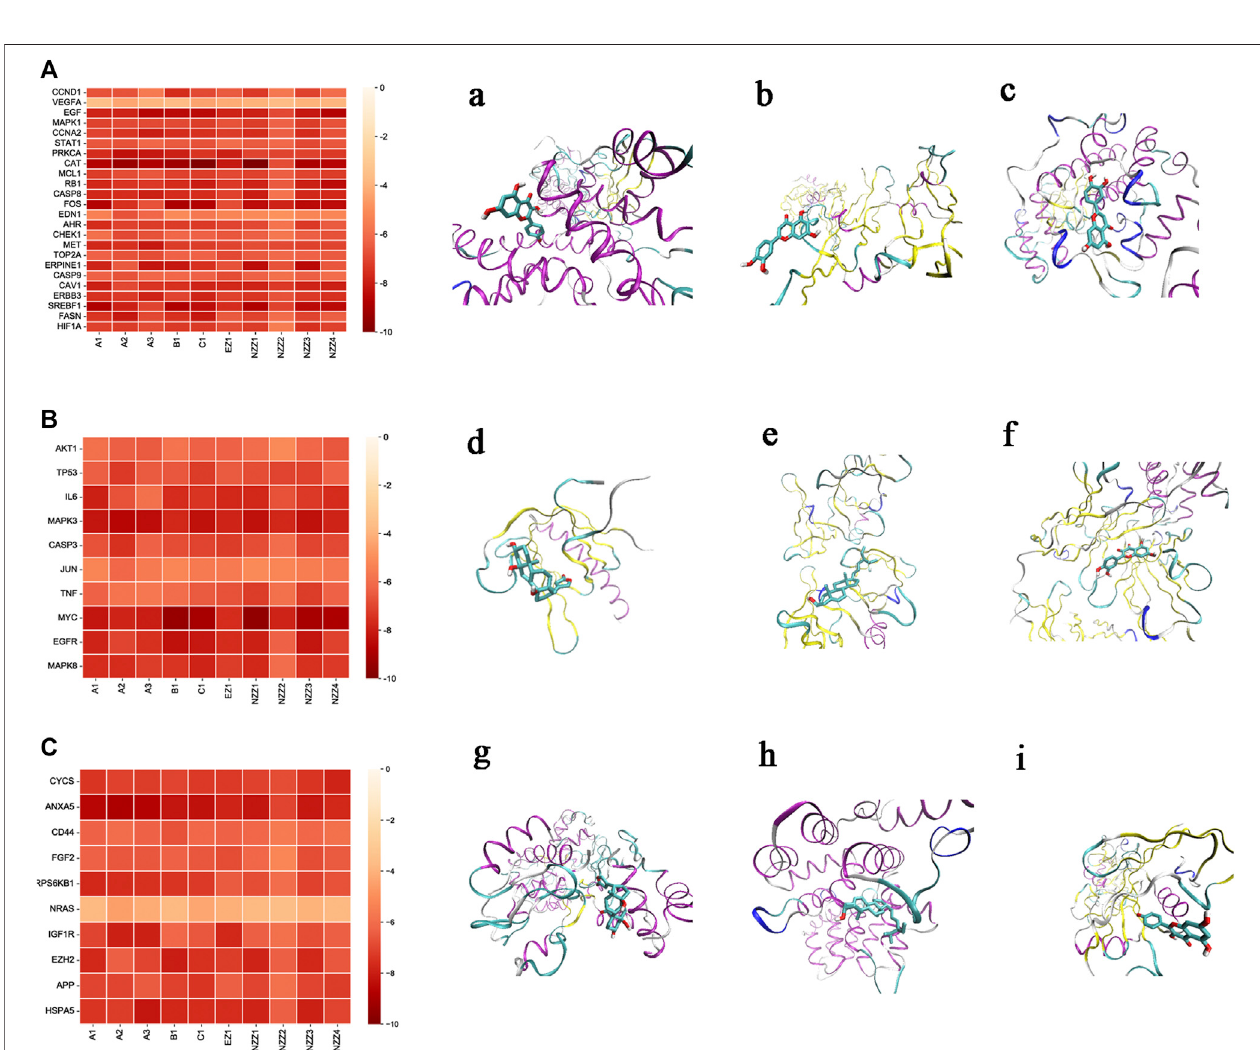
FIGURE7| Moleculardockingresults.Notes: (A) :Dockingresultsdiagramofcommontargetsandsmallmolecules. (a) :ThecorrespondingproteinofCCND1was visualized by docking with small molecule B1 with a docking score of − 7.6 kcal mol − 1 . (b) : VEGFA corresponds to the protein visualized by docking with small molecule C1 with a docking score of − 4.4 kcal mol − 1 . (c) : MAPK1 corresponds to the protein visualized by docking with the small molecule C1 with a docking score of − 7.2 kcal mol − 1 . (B) : Diagram of System Pharmacology model targets and small molecule docking results. (d) : The corresponding protein of AKT1 was visualized by docking with the small molecule NZZ4, with a docking score of − 6.6 kcal mol − 1 . (e) : TP53 corresponding protein was visualized by docking with small molecule A2 with a docking score of − 7.3 kcal mol − 1 . f: IL6 corresponds to the protein visualized by docking with small molecule A1 with a docking score of − 7.9 kcal mol − 1 . (C) : Diagramofdockingresultsofmodeltargetsandsmallmoleculesofgenechip. (g) :CYCScorrespondstotheproteinvisualizedbydockingwiththesmallmoleculeNZZ4 withadockingscoreof − 7.8 kcal mol − 1 . (h) :ANXA5correspondstotheproteinvisualizedbydockingwithsmallmoleculeA2withadockingscoreof-8.9 kcal mol − 1 . (i) : The CD44 counterpart protein was visualized by docking with small molecule B1 with a docking score of − 7.9 kcal mol − 1 .